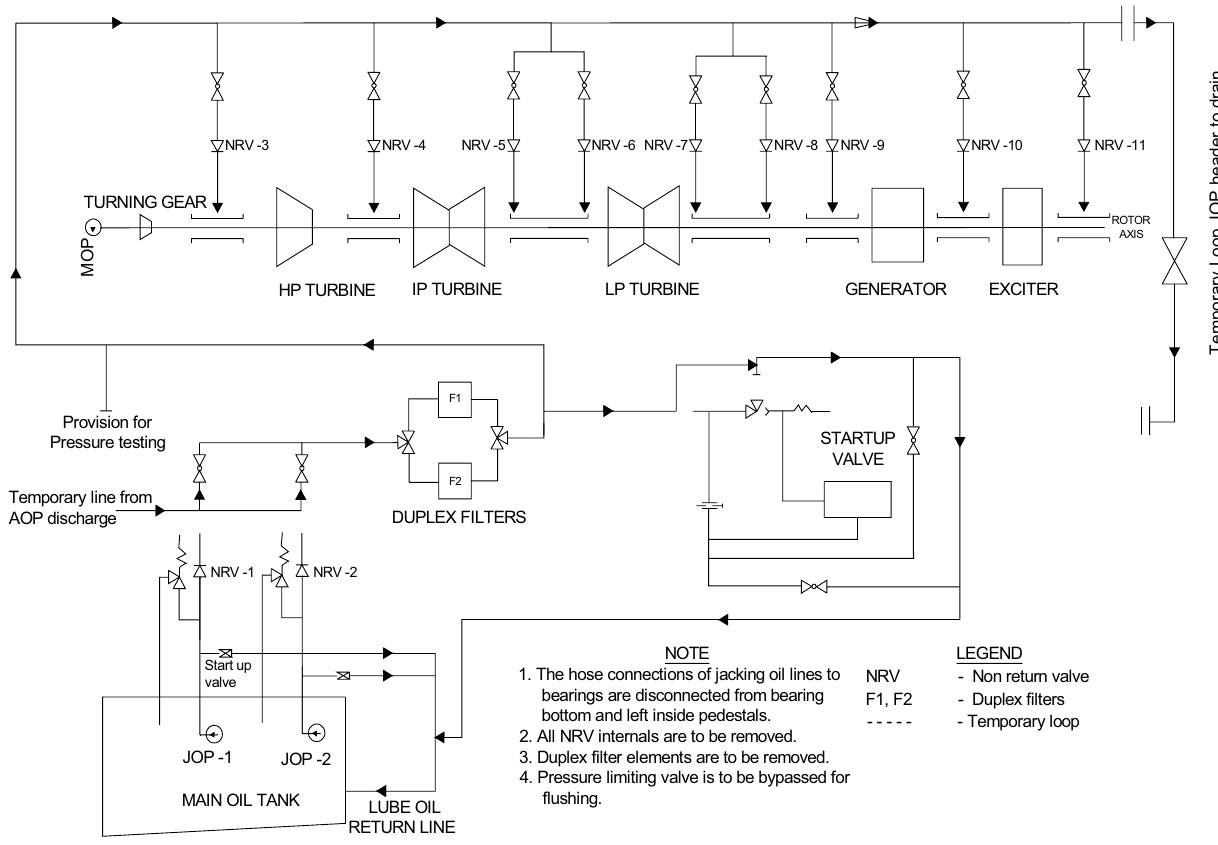
Fig. 2 Jacking oil system flushing scheme